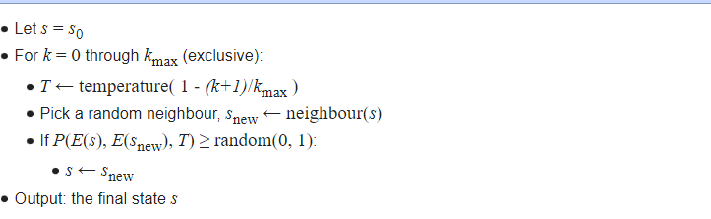
Figure 3. The pseudocode of simulated annealing (SA).